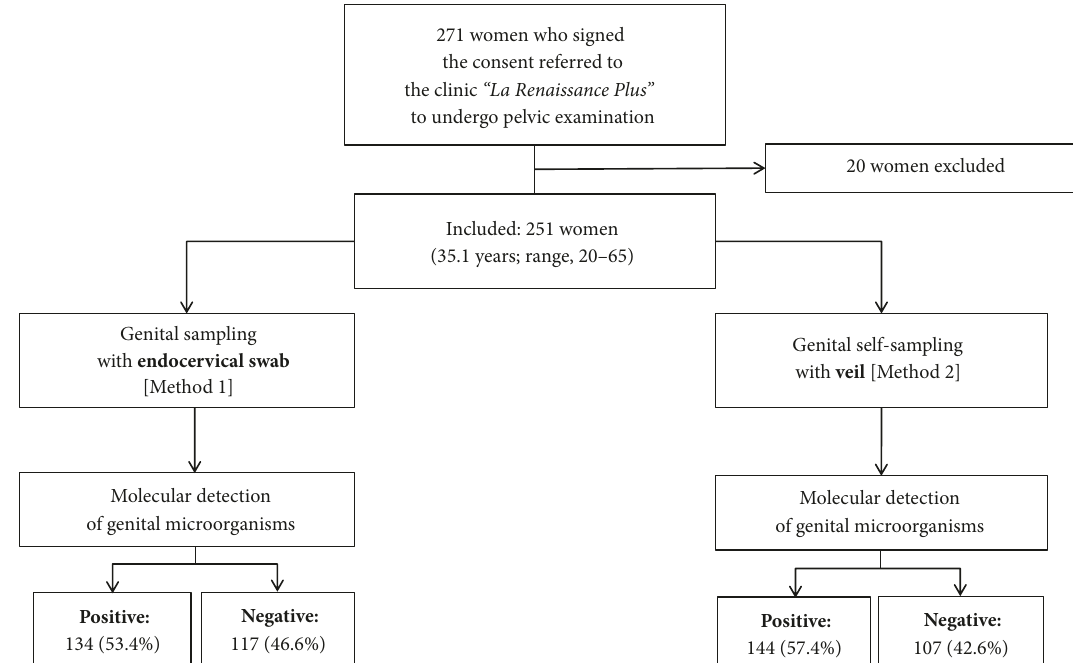
Figure 3: Flow diagram of study recruitment, specimen collection, and results of molecular detection by multiplex real-time PCR of genital microorganisms, including common curable sexually transmitted infections (STIs) and commensal